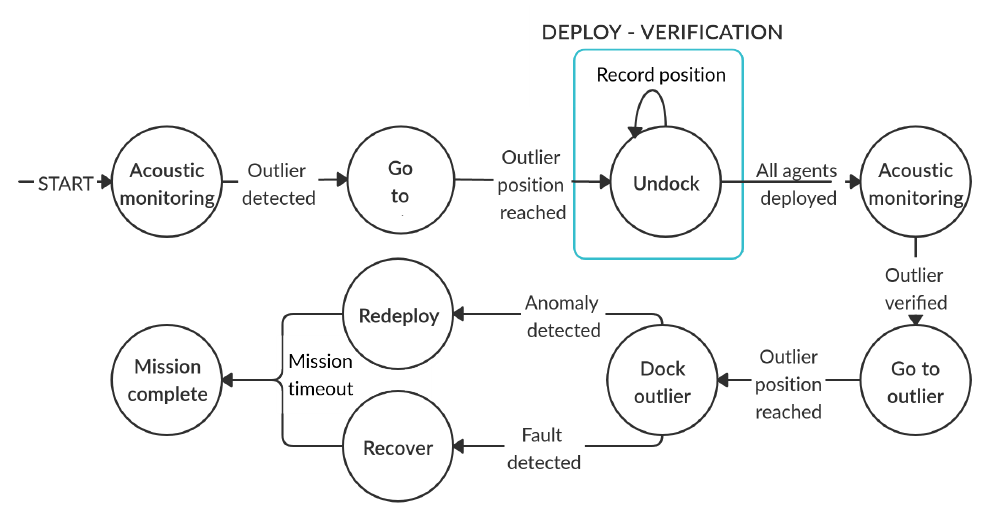
Figure 7. Anoxia scenario experiment for the aPad deploying verification group agents (aPad P 2